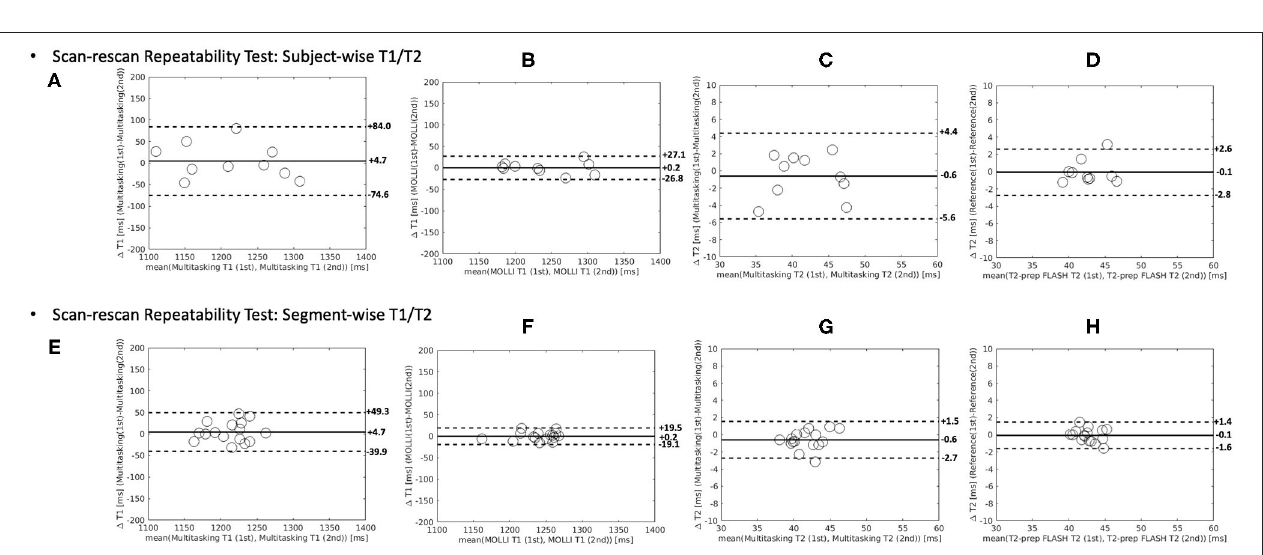
FIGURE 8 | (A) The 16-segment AHA model for the 2D single-slice Multitasking T1/T2 maps in the myocardium in all 10 healthy subjects. (B) The Bland-Altman plot compares the subject-wise global myocardium T1/T2 differences between Multitasking-SS and Multitasking-SMS in 10 healthy subjects. (C) The Bland-Altman plot compares the segment-wise T1/T2 differences between Multitasking-SS and Multitasking-SMS in 10 healthy subjects. The dash lines represent 95% limits of agreement, and the solid lines represent mean bias.